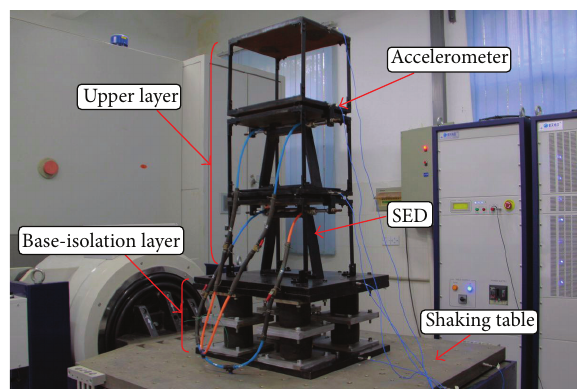
Figure 1: Test base-isolated building model on shake table.